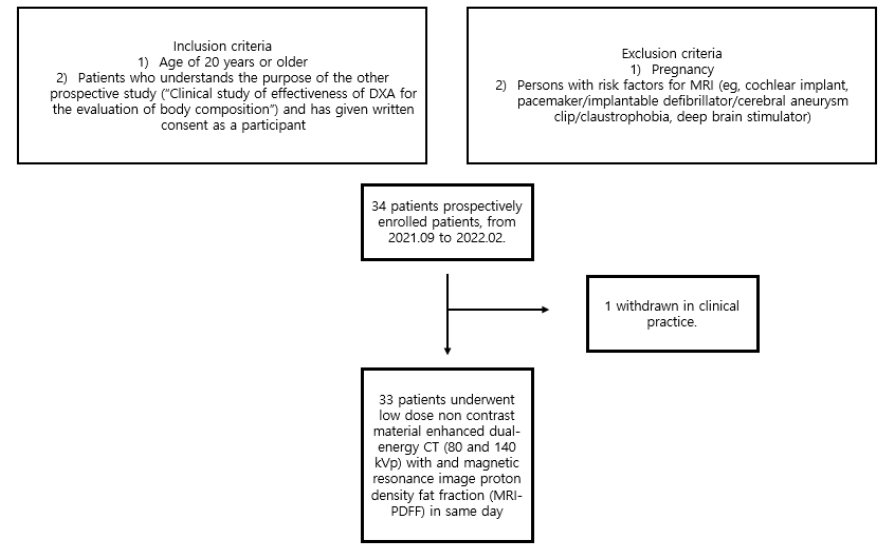
Figure 1. Flow diagram of the study population.